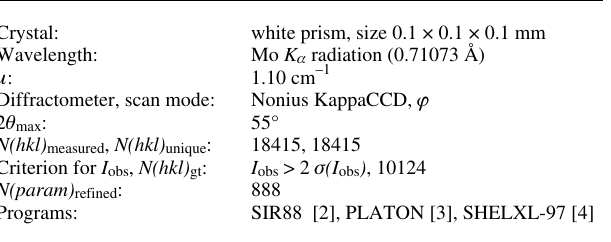
Table 1. Data collection and